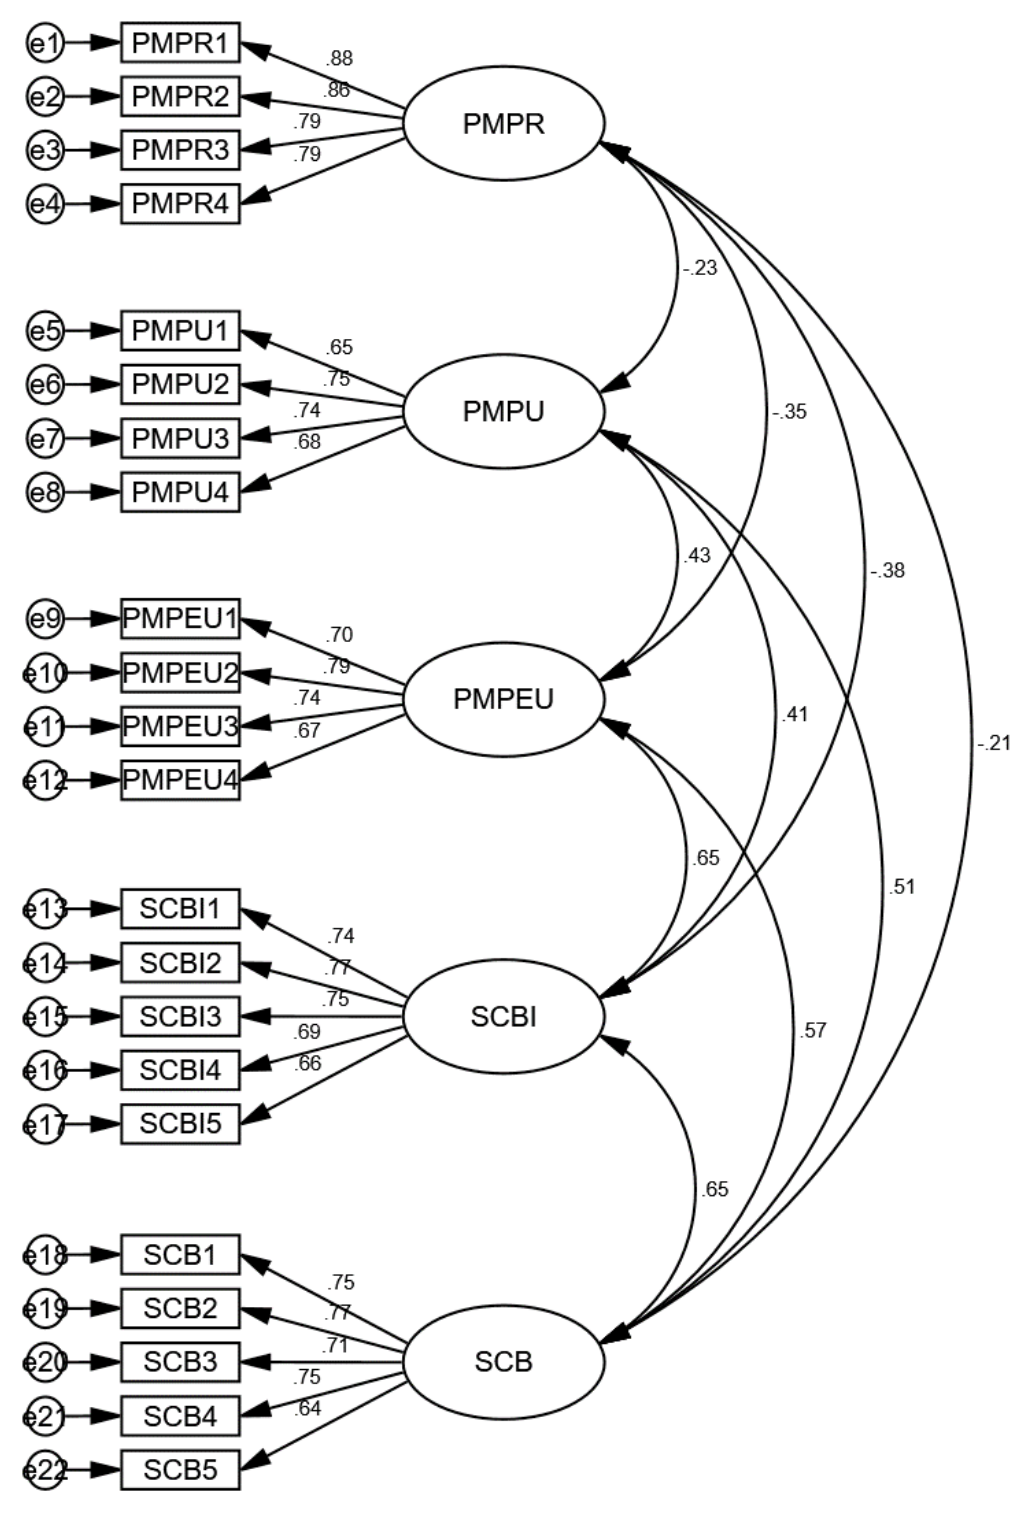
Figure 1. Confirmatory factor